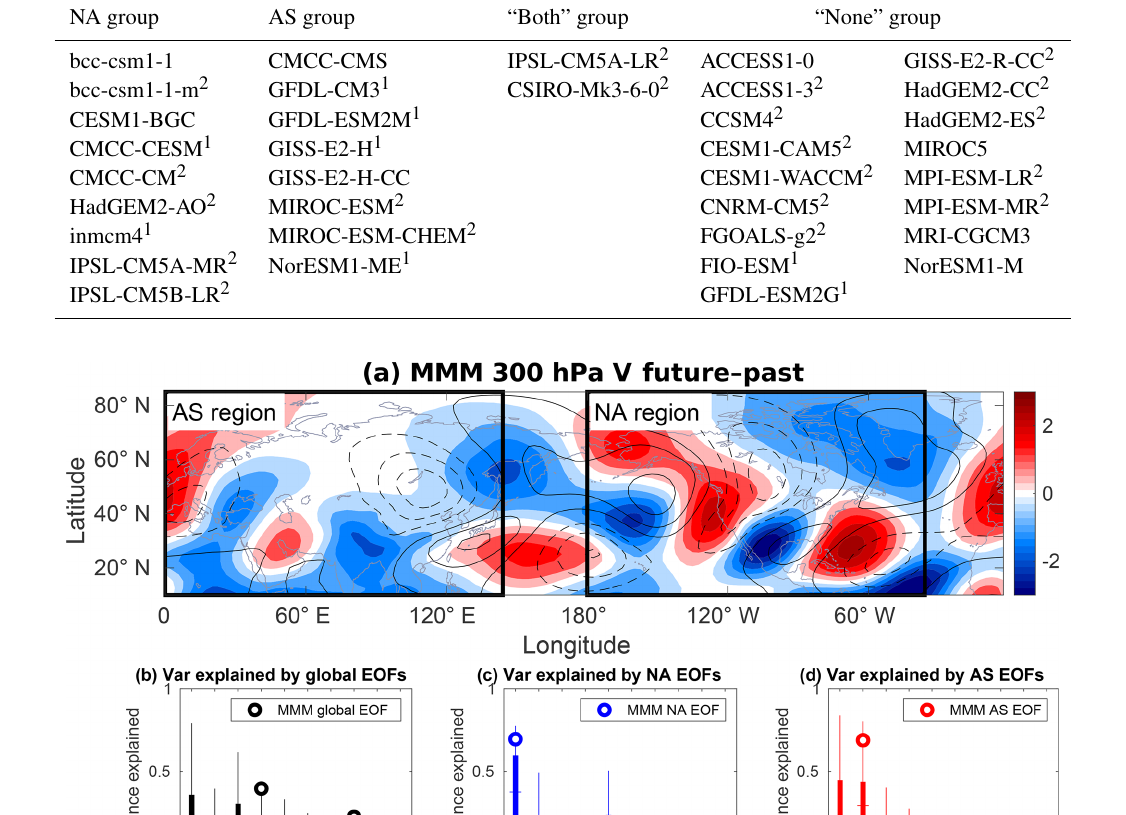
Table 1. CMIP5 model groups based on preferred regional CTP phasing of monthly mean data projection. Models where global EOF2 and EOF3 are well-separated are denoted by ( 1 ). When all three leading functions are well-separated, the models are denoted by ( 2 ).